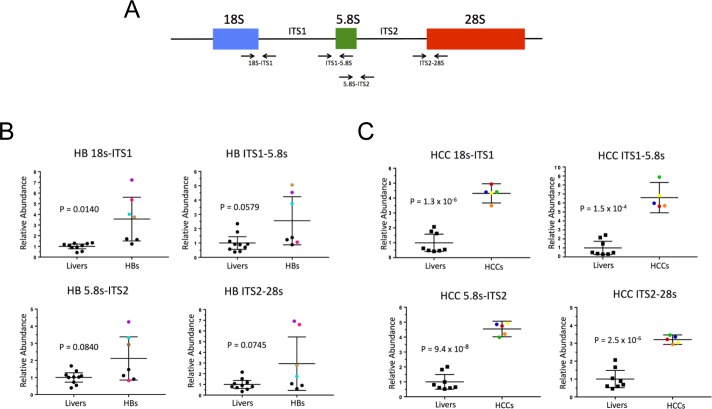
Incomplete processing of rRNAs in HBs and HCCs.(A) Normal rRNA processing. Arrows depict regions amplified by qRT-PCR to quantify 18S-ITS1, ITS1-5.8S, 5.8S-ITS2 and ITS2-28S junctional fragments common to all rRNA precursors. (B) Quantification of each of the above four junctions in control livers and HBs. Identically colored dots represent the same tumor RNA sample within the subgroup of tumors that demonstrated abnormal processing of at least one junction. Control livers and tumors with no significant processing differences are depicted in black. (C) Similar quantification of RNA processing in HCCs. Data in (B) and (C) were normalized to levels of total 18S and 28S RNA. Each qRT-PCR reaction was performed in triplicate and the mean is depicted.